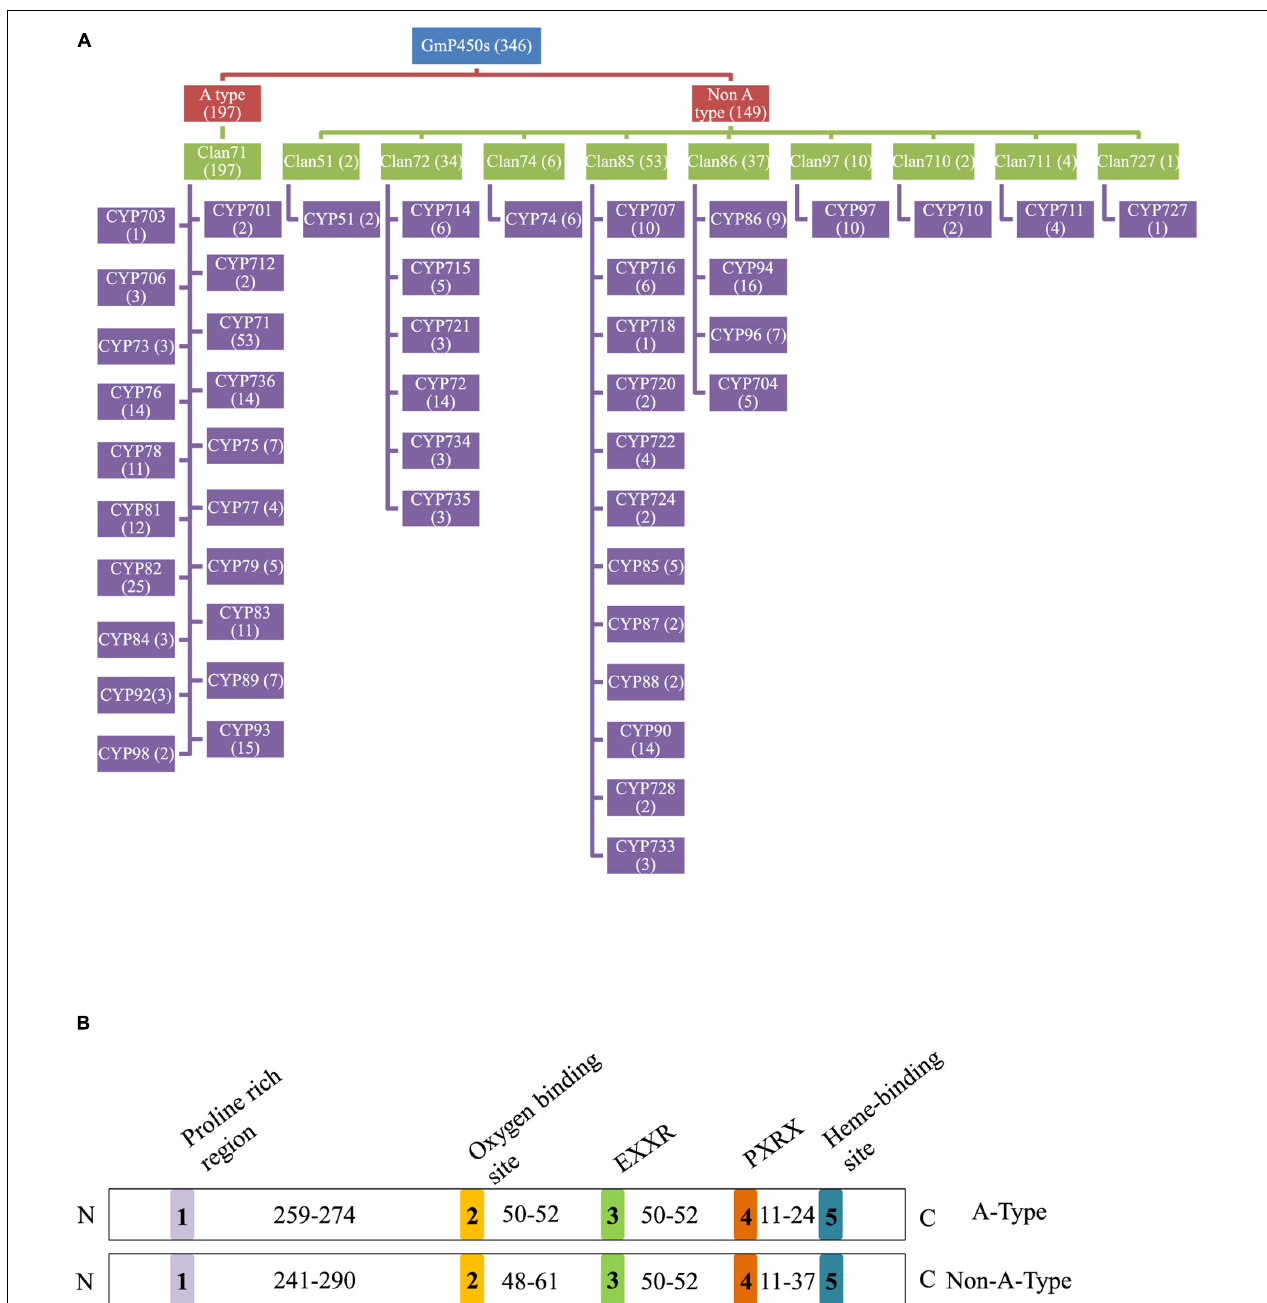
FIGURE 3 | Soybean P450s. (A) A flowchart showing the distribution of GmP450s in clans and CYP families. GmP450 type, clans and families are color coded. The number of GmP50s under each category is indicated within the parenthesis. (B) Conserved motifs and number of amino acid residues in the variable regions in GmP450s. Five conserved P450 motifs are color coded and indicated by 1–5. The number of amino acid residues present in the variable region between conserved motifs is shown. N and C denotes the N-terminal and C-terminal of protein,